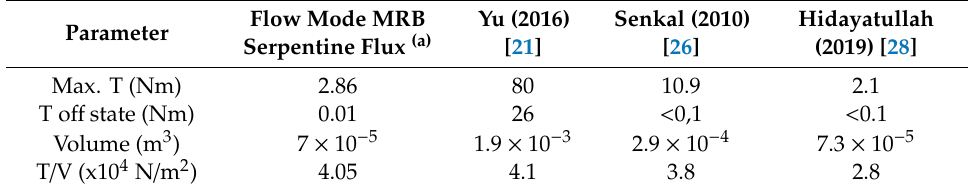
Table 4. Rotary MR damper performance